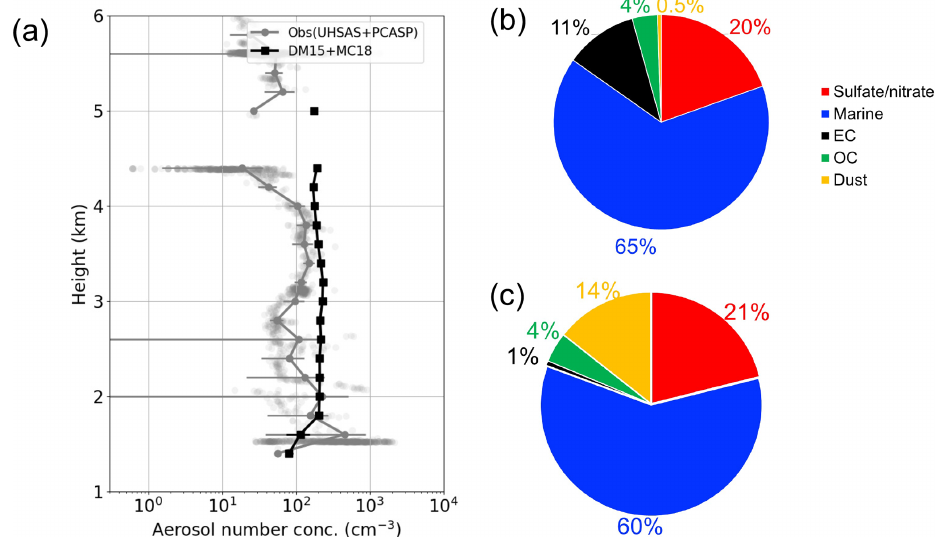
Figure 3. (a) Vertical distributions of aerosol number concentrations from aircraft observations (Obs, gray) and DM15 + MC18 (black) for particles with a dry diameter over a range of 0.067–3µm, (b) mean fractional number contributions of aerosol classifications based on measurements of single-particle mass spectra of aerosols and cloud particle residuals reported in Levin et al. (2019), and (c) mean fractional mass contributions of aerosols in DM15 + MC18 (number concentration for each aerosol component is not predicted by WRF-Chem). The aerosol number concentration from aircraft observations in (a) consists of both measurements from UHSAS and PCASP. The modeled data in (a) and (c) are sampled along the aircraft route on 7 February